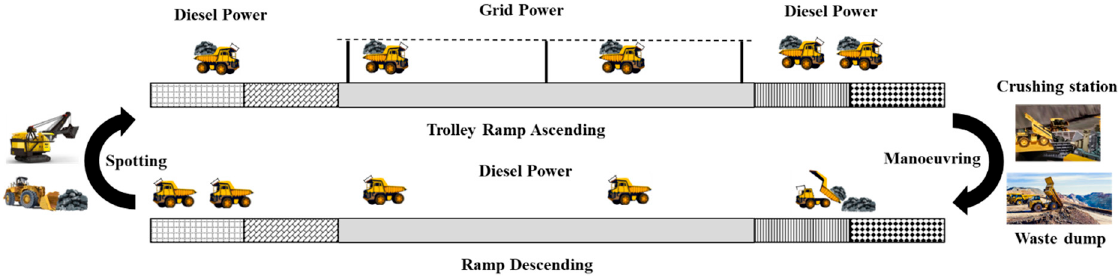
Figure 10. A schematic of a typical TA operation and power